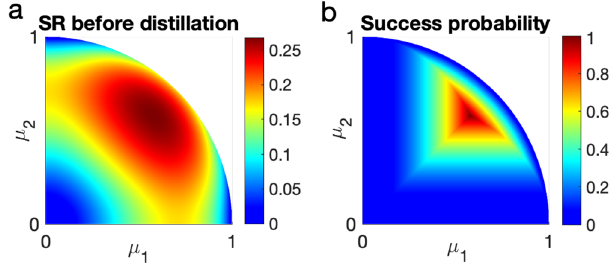
Fig. 2 | Results of the qutrit assemblage before and after the fi lter with the successprobability.a SteeringrobustnessSRofthequtritassemblagesbeforethe fi lter. Here, the qutrit assemblages are generated by the purely entangled qutirt (cid:8) state ∣ ψ = ∑ i μ i ∣ ii i satisfying ∑ i μ 2 i =1 and 1> μ i >0 ∀ i with Alice's measurements being two mutually unbiased bases in dimension three. b Success probability of distilling qutrit assemblages using Eq. (11). After the fi lter protocol, the steering robustnessis0.2679 ∀ μ 1 ,and μ 2 .Thewhiteregionrepresentsthenonphysicalcase because μ 2 1 + μ 2 2 ≥ 1 cannot be satis fi